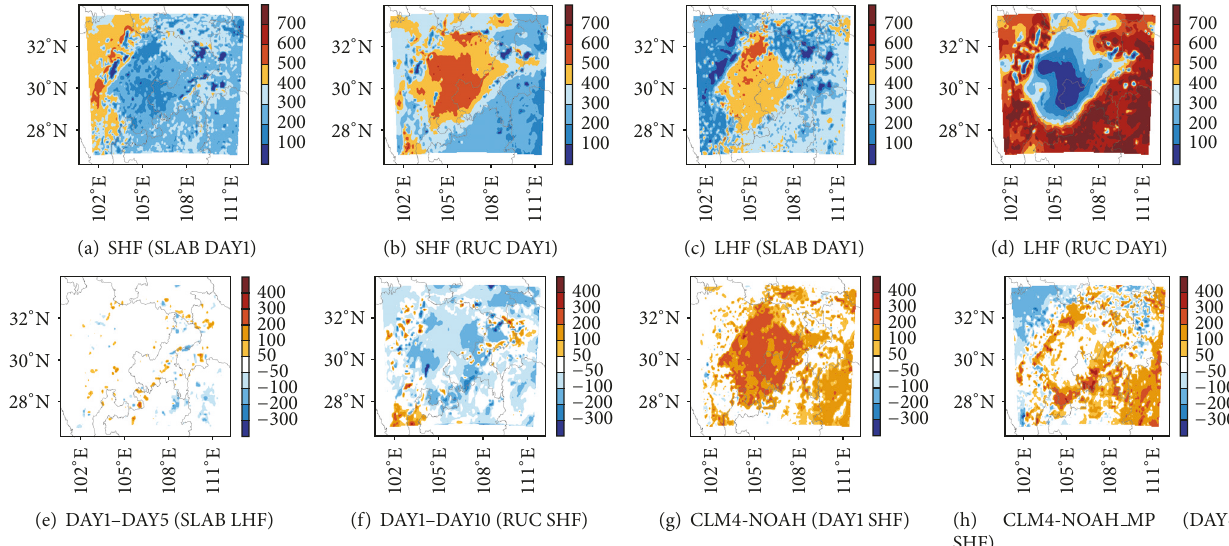
Figure 7: Distributions of SHF and LHF at 06 UTC on August 10 simulated by the SLAB and RUC LSSs (a–d); distributions of SHF and LHF difference fields at 06 UTC on August 10 with the different LSSs and simulation lengths (e–h) (units: Wm −2